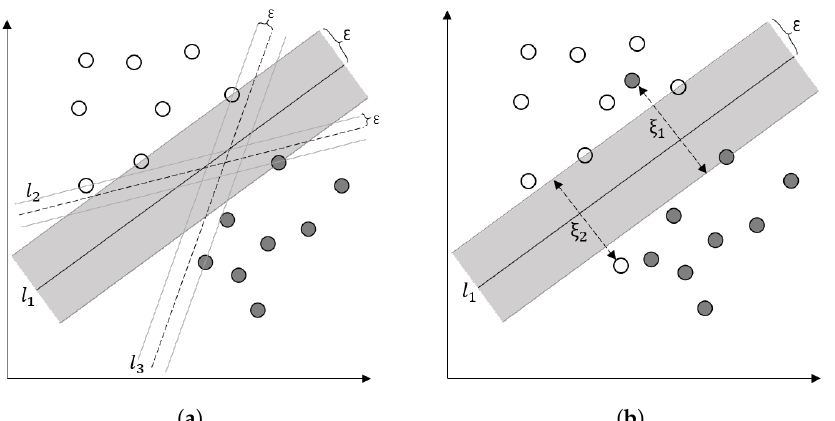
Figure 7. Observations are transformed to a higher-dimensionality space (for simplicity, a 2D space). ( a ) Among all possible hyperplanes (line or curves in the current 2D example), the hyperplane that maximizes the margin (cid:101) is optimum ( l 1 ). ( b ) In practice, outliers exist in observations. While there is still a hyperplane that can separate the two classes, it may result in